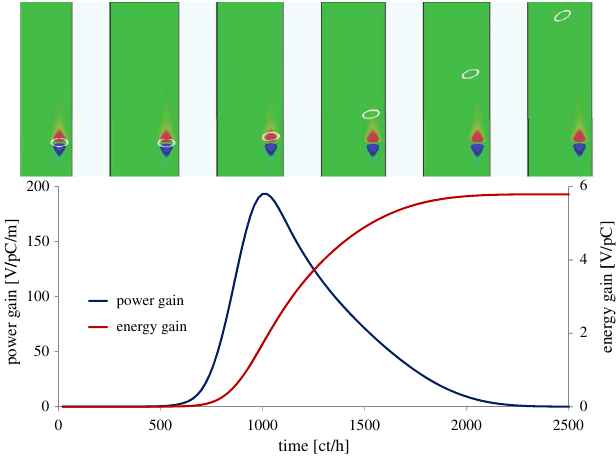
FIG. 7. The electric field distribution on the horizontal plane in the vertical center of the vacuum chamber and a bunch position at different times. The red color corresponds to a high positive value of the field and the blue color corresponds to a low negative value of the field. The white oval shows the real bunch contour. Coherent power and energy gain are shown by a blue and a red curve.